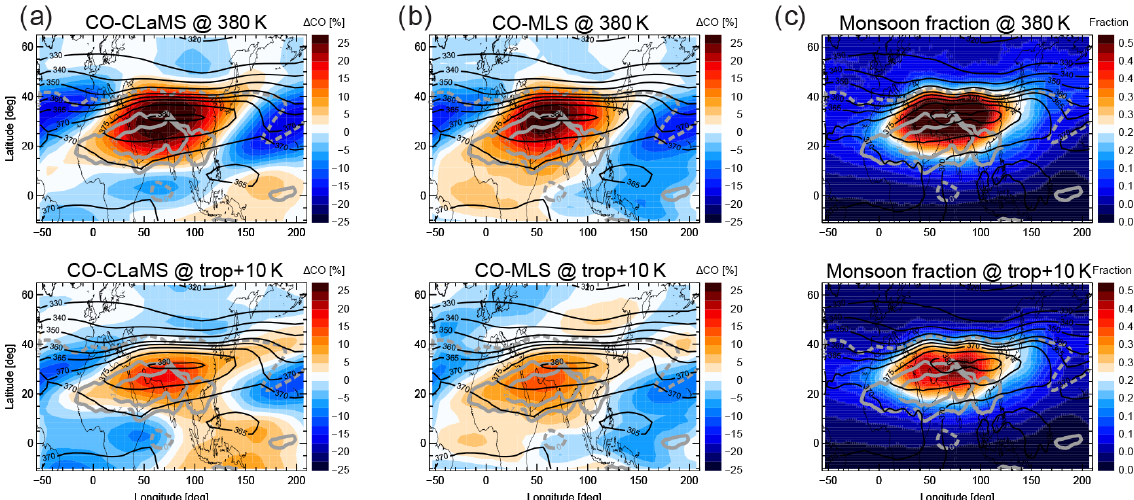
Figure 3. Maps of (a) carbon monoxide from CLaMS simulation, (b) CO from MLS satellite observations, and (c) monsoon air mass fraction from CLaMS, all for July–September. Top panels show maps at 380K potential temperature, bottom panels show maps along a surface at 10K above the local (WMO) tropopause. For CO the deviation from the zonal mean is shown in percent ( (cid:49) CO). Black contours show the potential temperature of the local WMO tropopause, and grey contours cross-isentropic (diabatic) vertical velocity d θ/ d t (solid: 1, 1.3Kday − 1 ; dashed: 0Kday − 1 ). Note that d θ/ d t is shown at 380K. CO climatologies were calculated for the period 2004–2016, and air mass fraction climatologies for